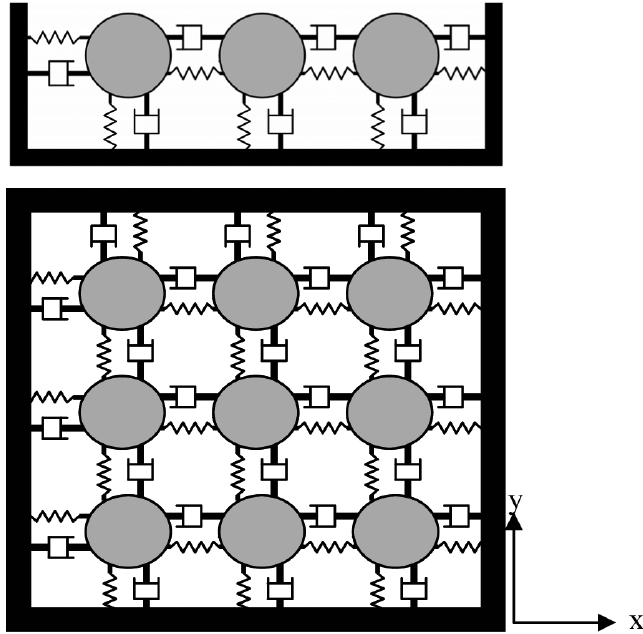
Fig. 3. Schematic model of DDA – Side view (upper sketch), Top view (lower sketch).